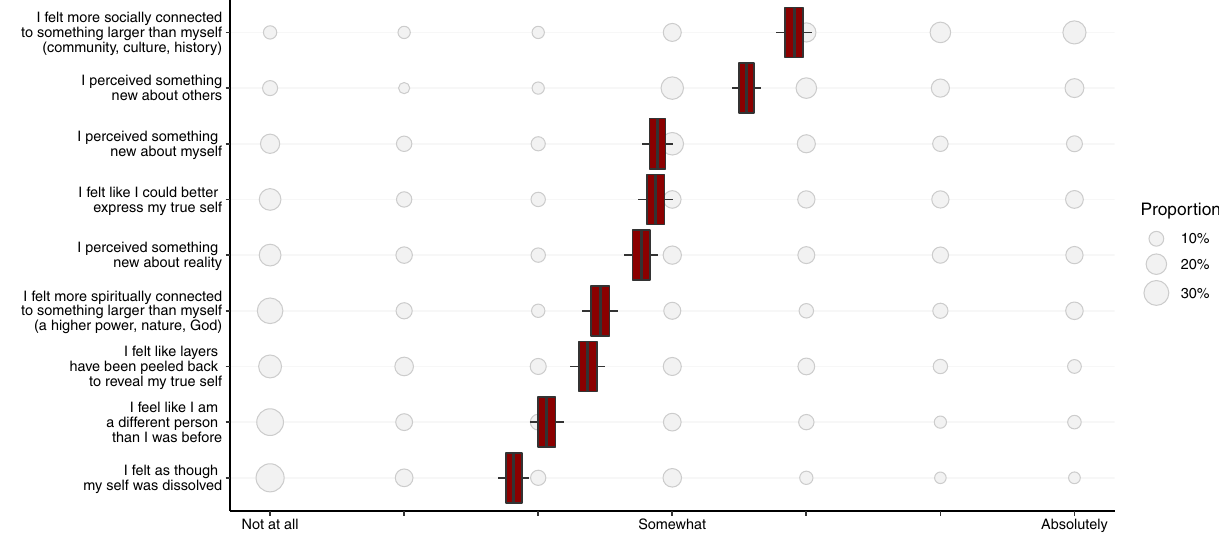
Fig. 3 Base rates of qualities of transformative experience among onsite participants ( n = 1215 observations examined over 6 fi eld studies). Bubble size re fl ects proportion providing that response within each question. Box centers indicate the mean value, edges SEM, box whiskers 95% CI. Source data are provided as a Source Data fi